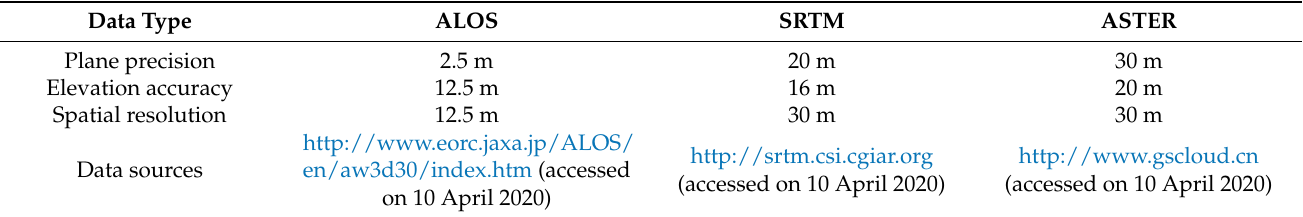
Table 2. ALOS, SRTM and ASTER data